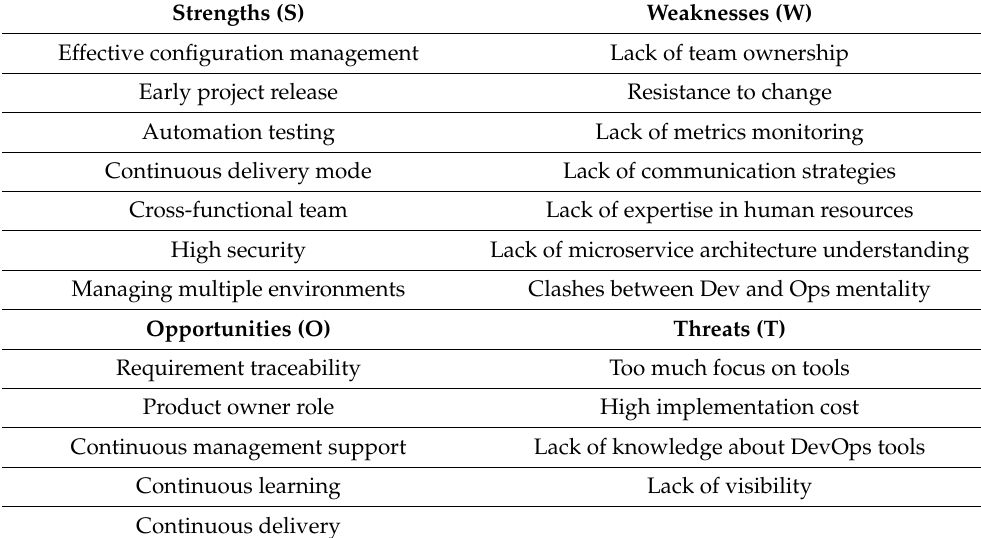
Table 5. Categorization of the factors based on the SWOT categories. Strengths (S) Weaknesses